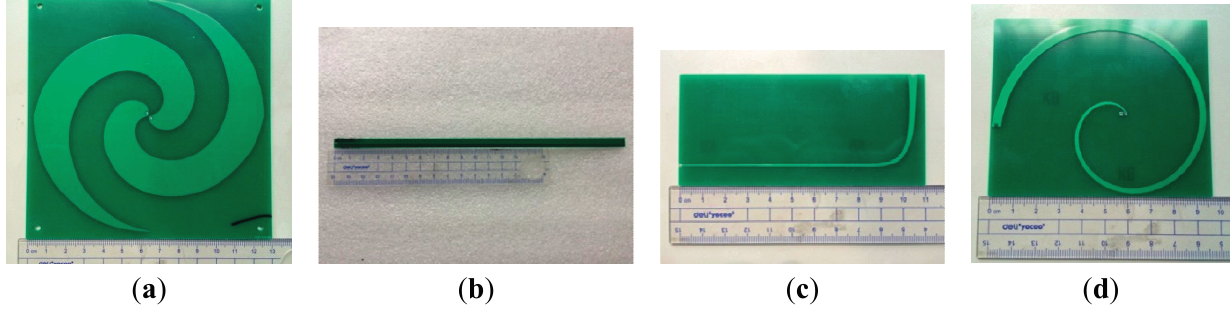
Figure 7. Manufactured prototype dimensions of the equiangular spiral antenna (ESA) and microstrip baluns. ( a ) ESA; ( b ) I-shaped balun; ( c ) L-shaped balun; ( d ) C-shaped balun.